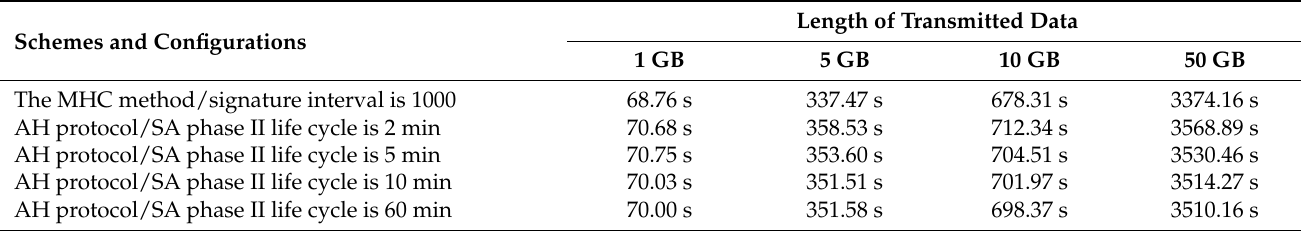
Table 4. The experimental results of the transmission efficiency of the AH protocol communication method and the MHC method.